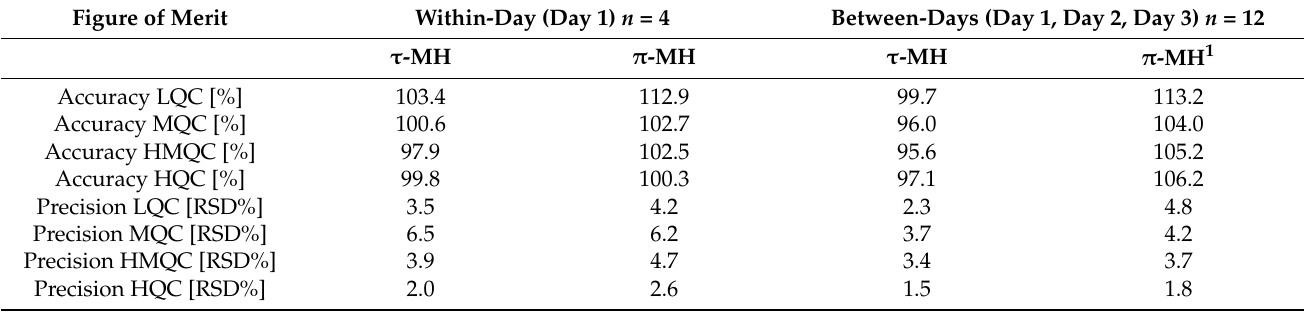
Table 2. Results for within-day and between-days trueness (%R) and precision (%RSD). All values appear to be within the acceptable validation